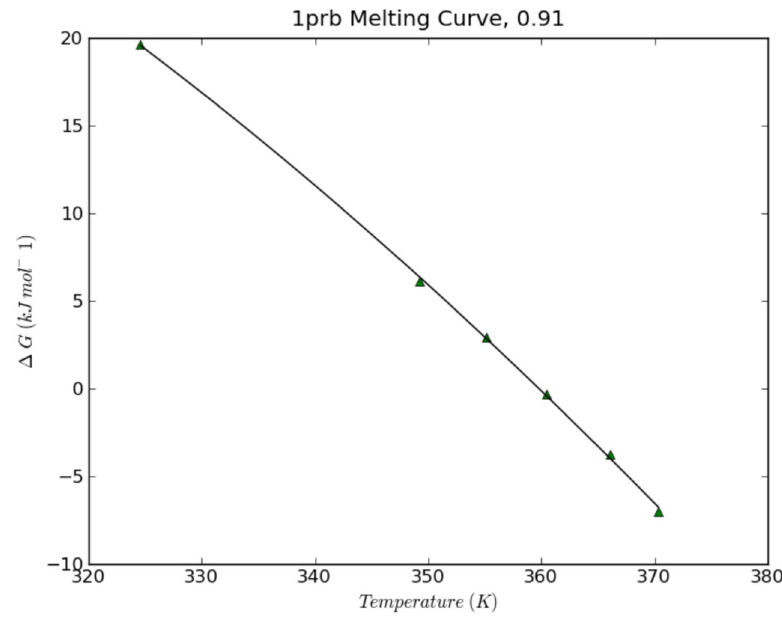
Figure 3. An example melting curve. Each point on the plot represents D G fold calculated from a full trajectory. T m occurs when D G fold ~ 0 , and the curvature of the plot is related to C p